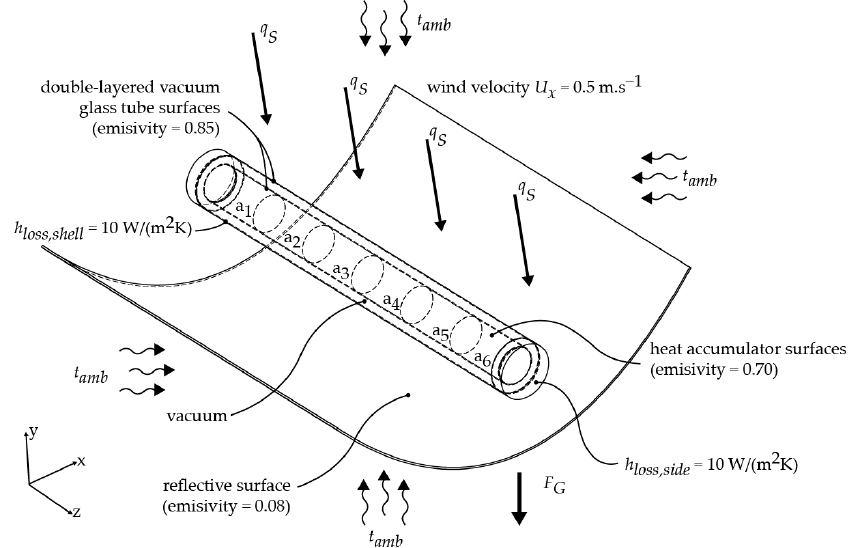
Figure 4. Basic layout and description of the calculation model.